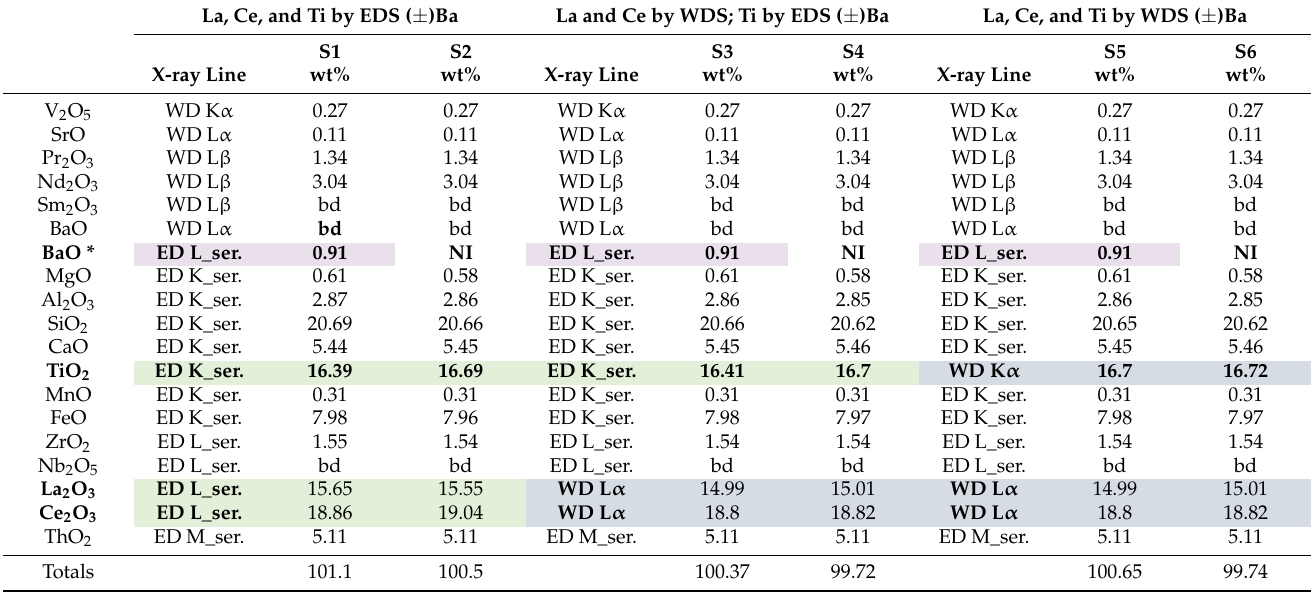
Table 3. Results of one SEM EDS-WDS quantitative dataset for chevkinite iteratively processed in different ways (S1–S6 are scenarios 1–6). BaO * was not detected by WDS but has been added here as an ED element to illustrate analytical challenges (NI = not included, bd = below